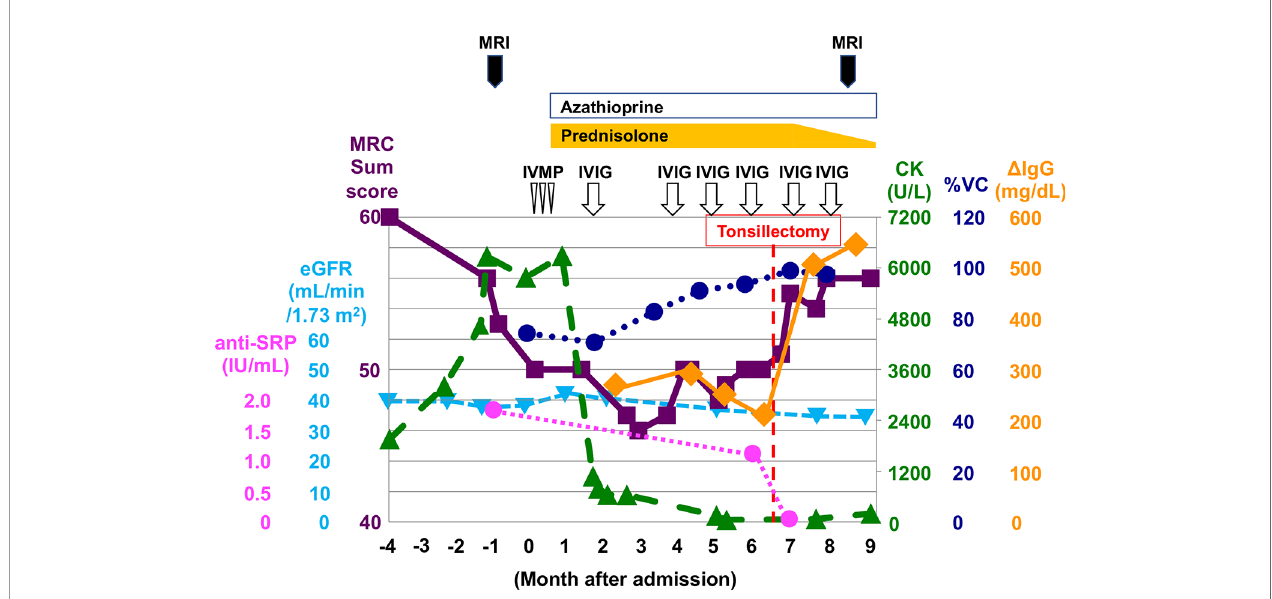
FIGURE 3 | Clinical course and treatments during hospitalization. Tonsillectomy (red dotted line) dramatically improved the therapeutic response to IVIG and was accompanied by a rapid increase in D IgG (increase in serum IgG levels 2 weeks after the start of IVIG treatment relative to pre-treatment levels). Purple square, Medical Research Council (MRC) sum score; light blue triangle, eGFR; magenta circle, anti-SRP antibody titer; green triangle, serum CK concentration; blue circle, % VC; orange diamond, D IgG; IVMP, intravenous methylprednisolone pulse therapy; IVIG, intravenous immunoglobulin